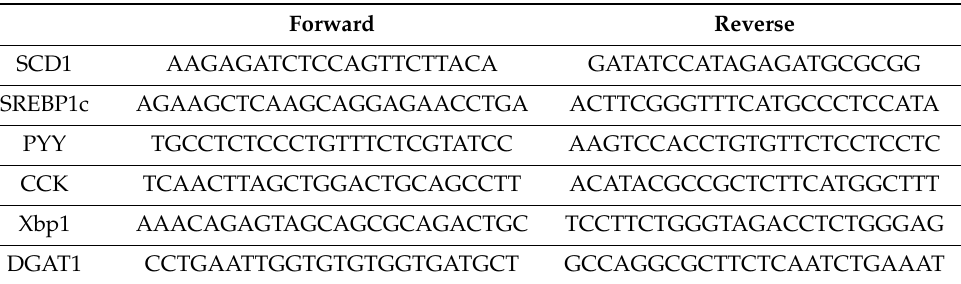
Table 3. Primers used for